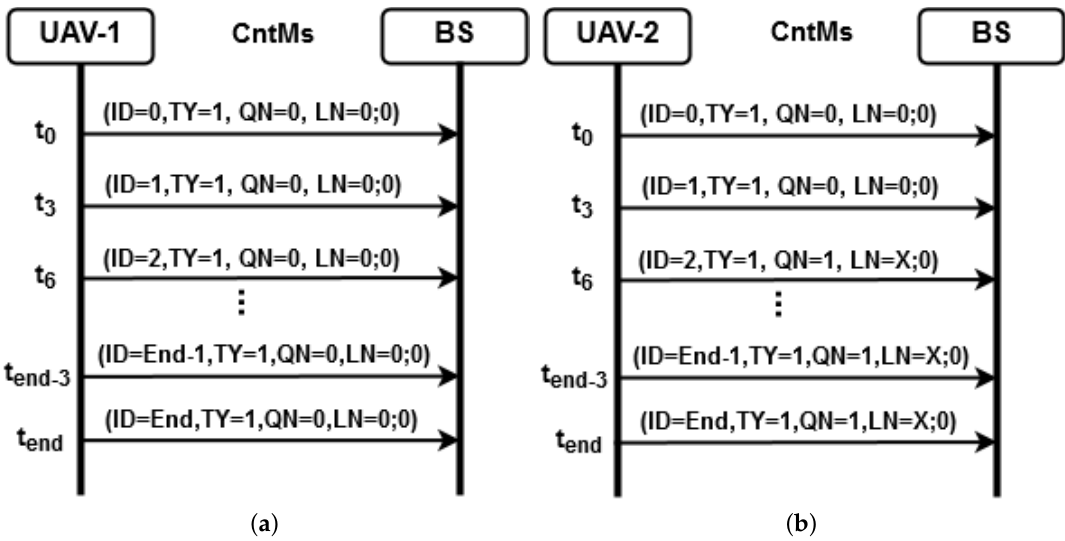
Figure 9. Flow of CntMs to the BS in a FANET: ( a ) UAV-1 completed the mission without detecting boats; ( b ) the imaging system located a boat, while informing the BS and preparing a DM.